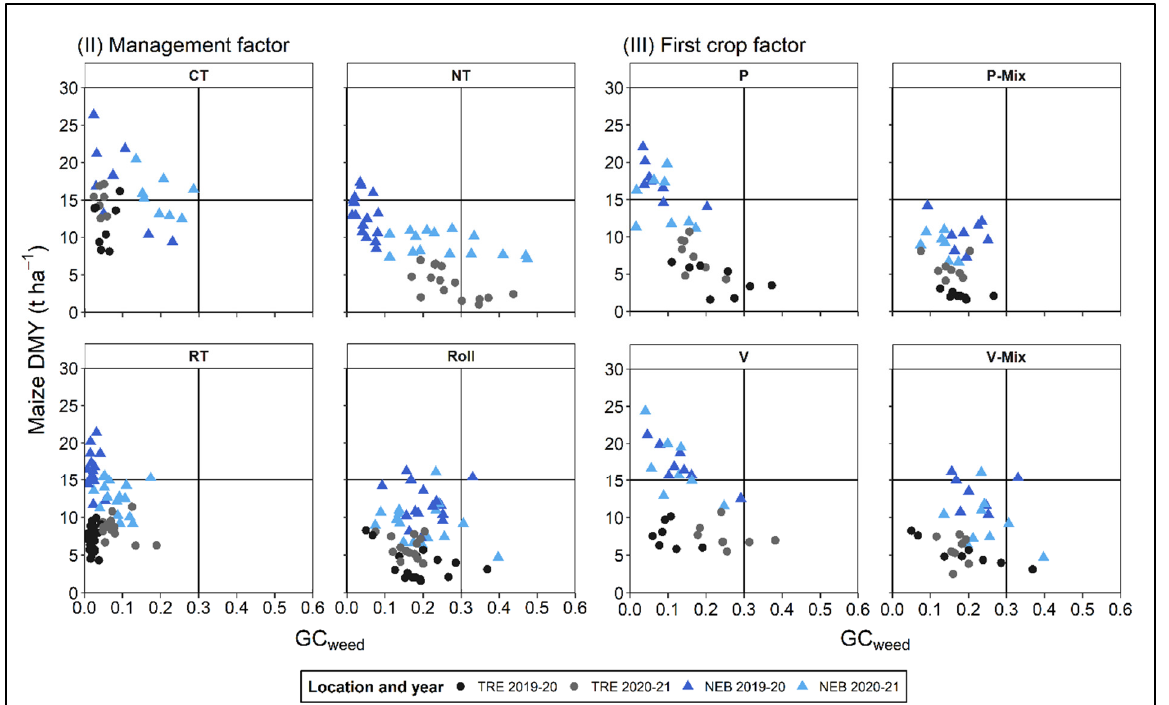
Figure A4. Relationship between weed groundcover (GC weed ) and maize dry matter yield (DMY, t ha ⁻ 1 ) over year and location with a focus on ( II ) Management factor and ( III ) First crop factor. Shape and colour represent location (shape and colour) and year (depth of colour). CT was included in focus ( II ) for completeness of important factors.